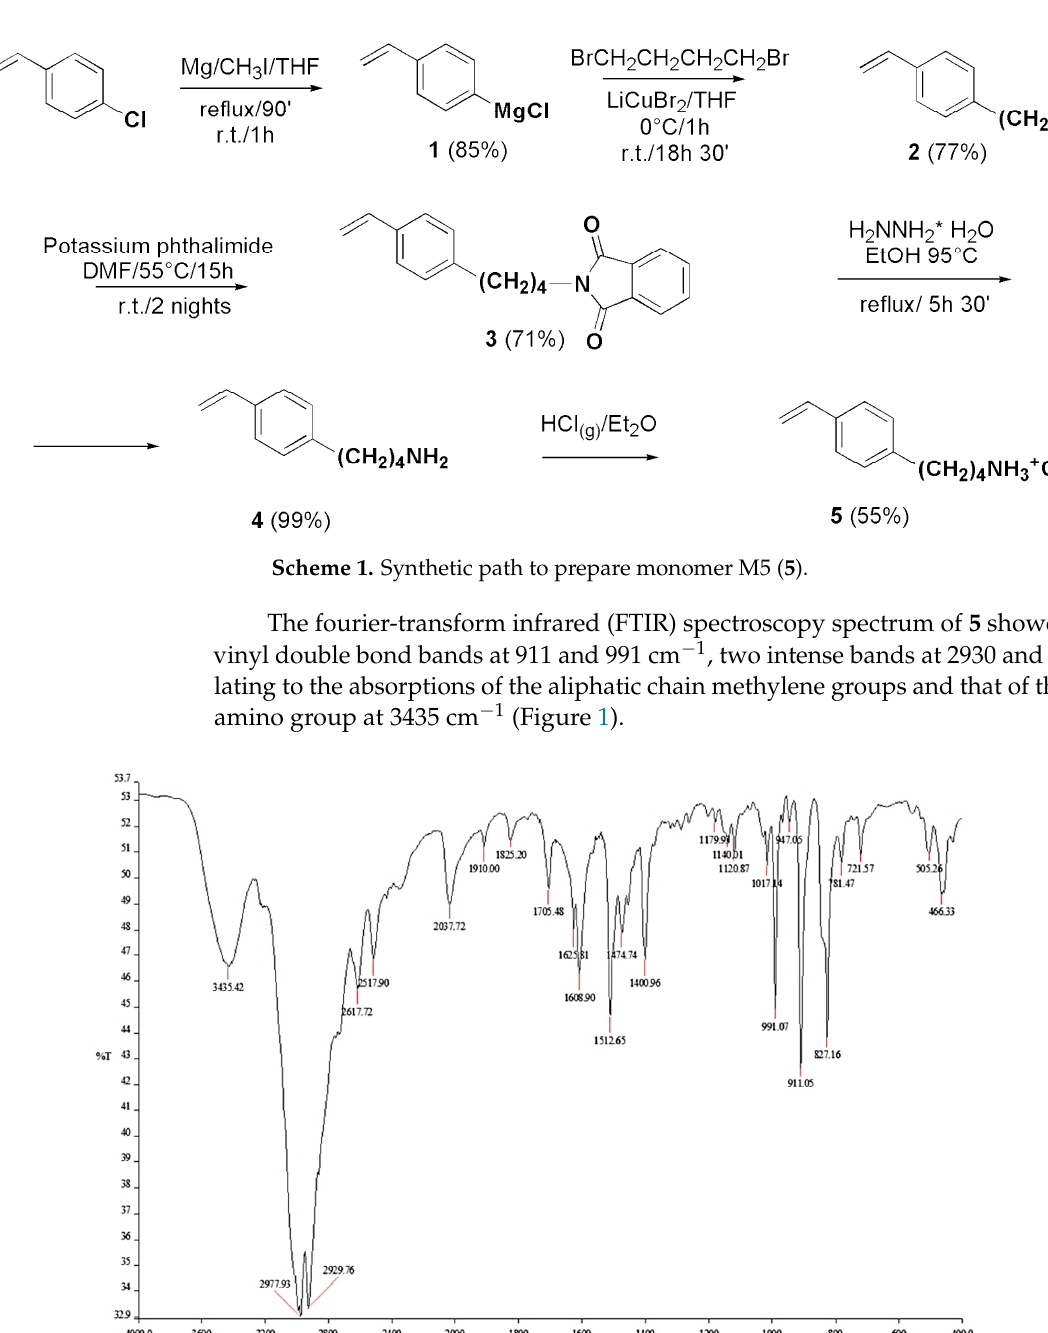
( b ) Figure 2. 1 H NMR (300 MHz), and ( a ) 13 C NMR (75.5 MHz), ( b ) spectra of monomer M5, ( 5 ) acquired in CD 3 OD. 3.2. Preparation of Copolymer P5 by Radical Copolymerization in Solution and its Spectroscopic Characterization Cationic random copolymers are the most reported macromolecular architectures studied as antimicrobial agents. They can be easily synthesized by merging an uncharged comonomer with a cationic monomer, thus, obtaining structures having charged, and not charged, moieties ‘randomly’ isolated along the polymer backbone [8]. Utilizing the more suitable comonomer and adjusting feed ratios, the amphiphilic character, and the hydro-